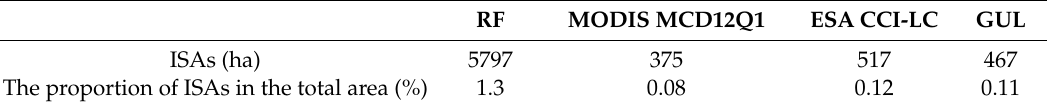
Figure 5. ISA maps in the Liping County for 2015 found by (a) Moderate Resolution Imaging Spectroradiometer Land Cover Type/Dynamics products (MODIS MCD12Q1), (b) European Space Agency Climate Change Initiative-Land Cover (ESA CCI-LC), (c) Global Urban Land (GUL), and (d) estimated by random forests classifier.